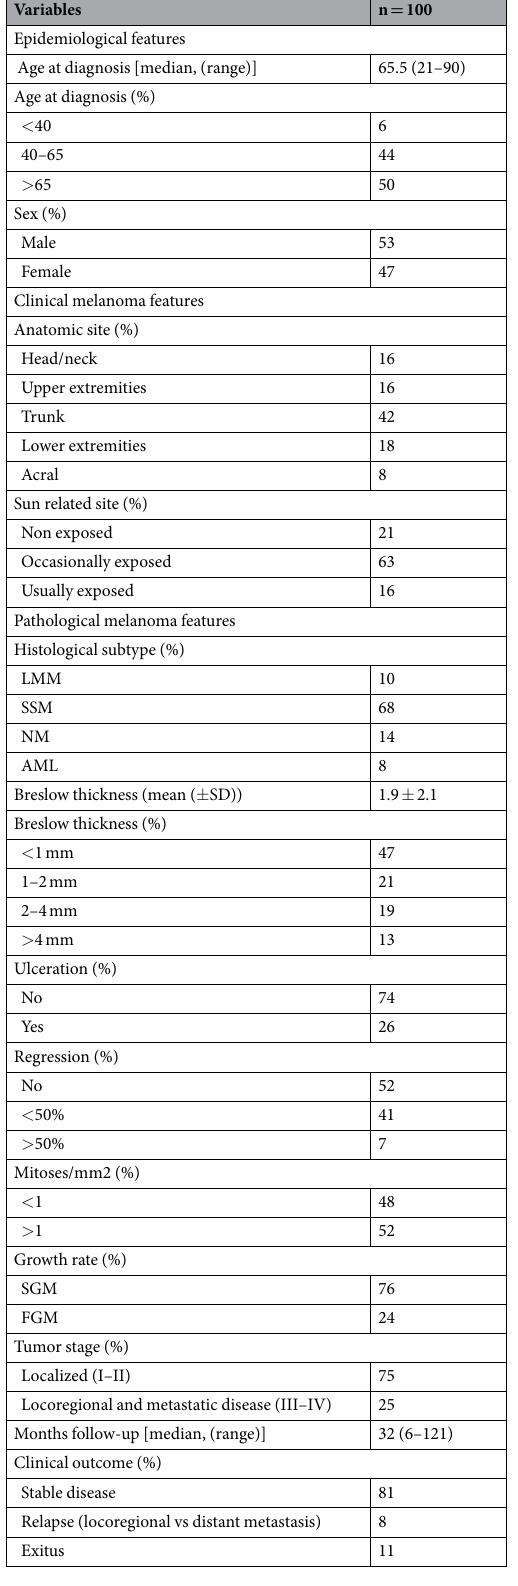
Table 5. Clinicopathological characteristics of the patients included in the